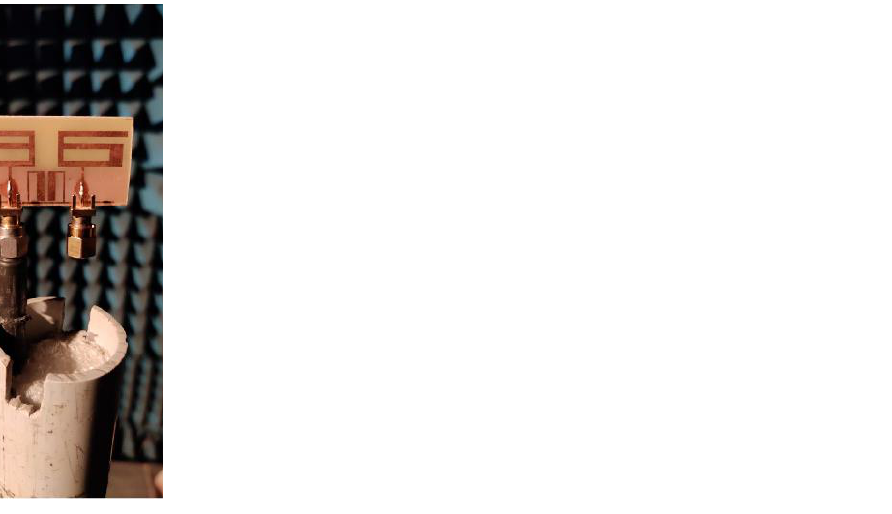
Figure 16. Measurement setup of anechoic chamber to measure radiation characteristics.